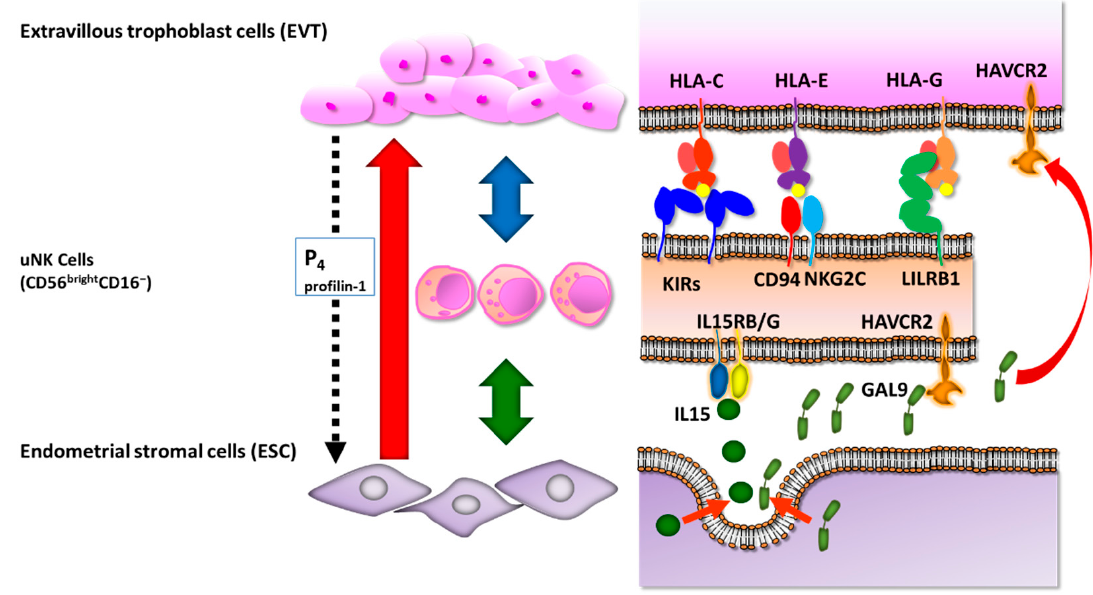
Figure 3. Molecular interactions among extravillous trophoblast cells, uterine natural killer (uNK) cells, and endometrial stromal cells. Extravillous trophoblast cells express human leukocyte antigen (HLA)-C, HLA-G, and HLA-E class I molecules and interact with killer cell immunoglobulin-like receptors (KIRs), activating C-type lectin receptor CD94/NKG2C, and leukocyte immunoglobulin-like receptor, subfamily B (LILRB1) on the surface of uNK cells to avoid immunological recognition. Endometrial stromal cells secrete interleukin (IL)-15 and galectin-9 (GAL9) to suppress inflammatory reactions of uNK cells via IL-15RB/G and Hepatitis A virus cellular receptor 2 (HAVCR2). EVT secretes progesterone (P4) and profilin-1 to regulate ESC decidualization.